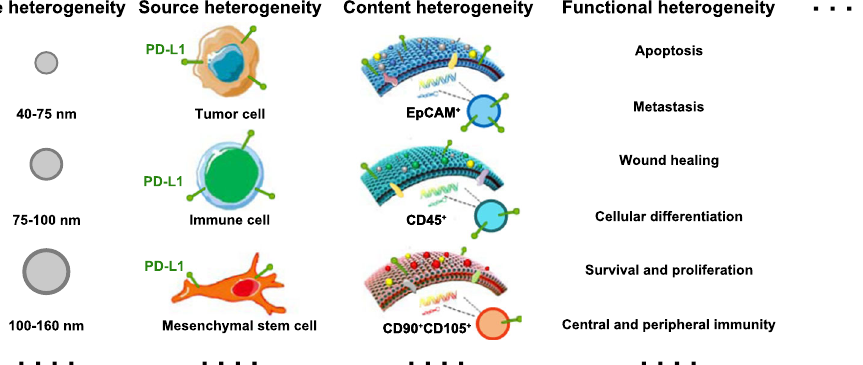
Fig. 6 The heterogeneity of sEV PD-L1. The heterogeneity of sEV PD-L1 may be conceptualized based on their size, cell of origin, content, and functional on recipient